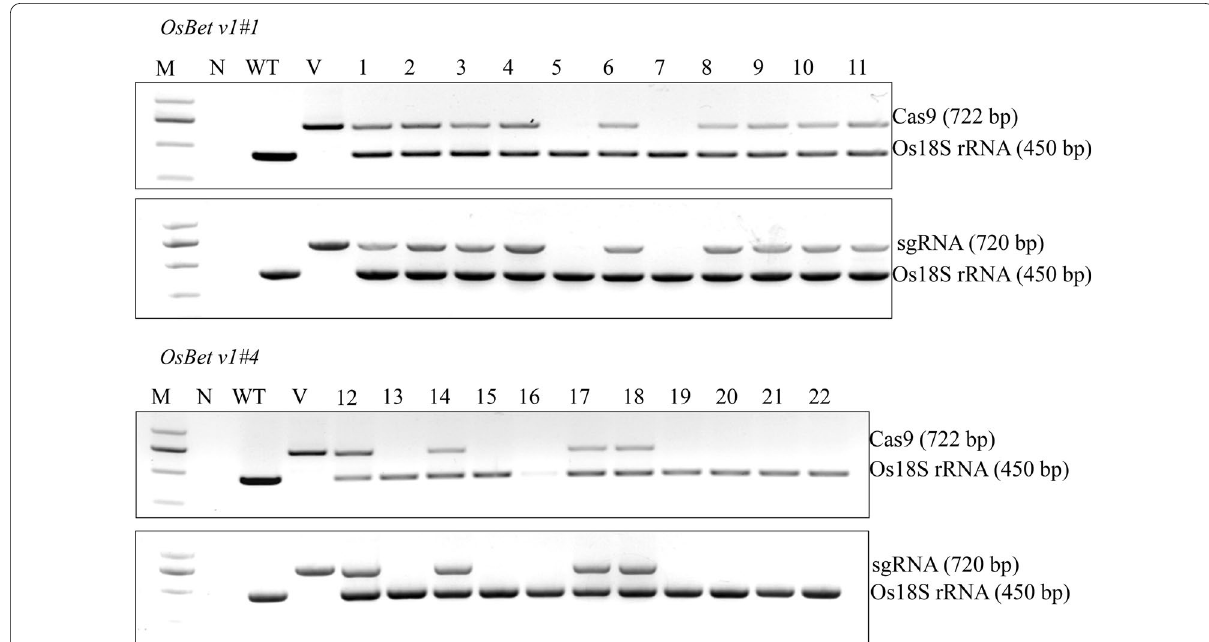
Fig. 5 Detection of ‘transgene-free’ homozygous OsBet v1 knockout mutants. Cas9 (722 bp), part of the Cas9-coding sequence; sgRNA (720 bp), a region spanning from the sgRNA to the downstream vector; Os18S rRNA (450 bp) was used as a normalization control; M, DL2000 DNA ladder; N, negative control with sterilized ddH 2 O as template; V, the plasmid vector; WT, wild-type plant. Lanes 1–11, 11 mutant individuals of OsBet v1#1 . Lanes 12–22, 11 mutant individuals of OsBet